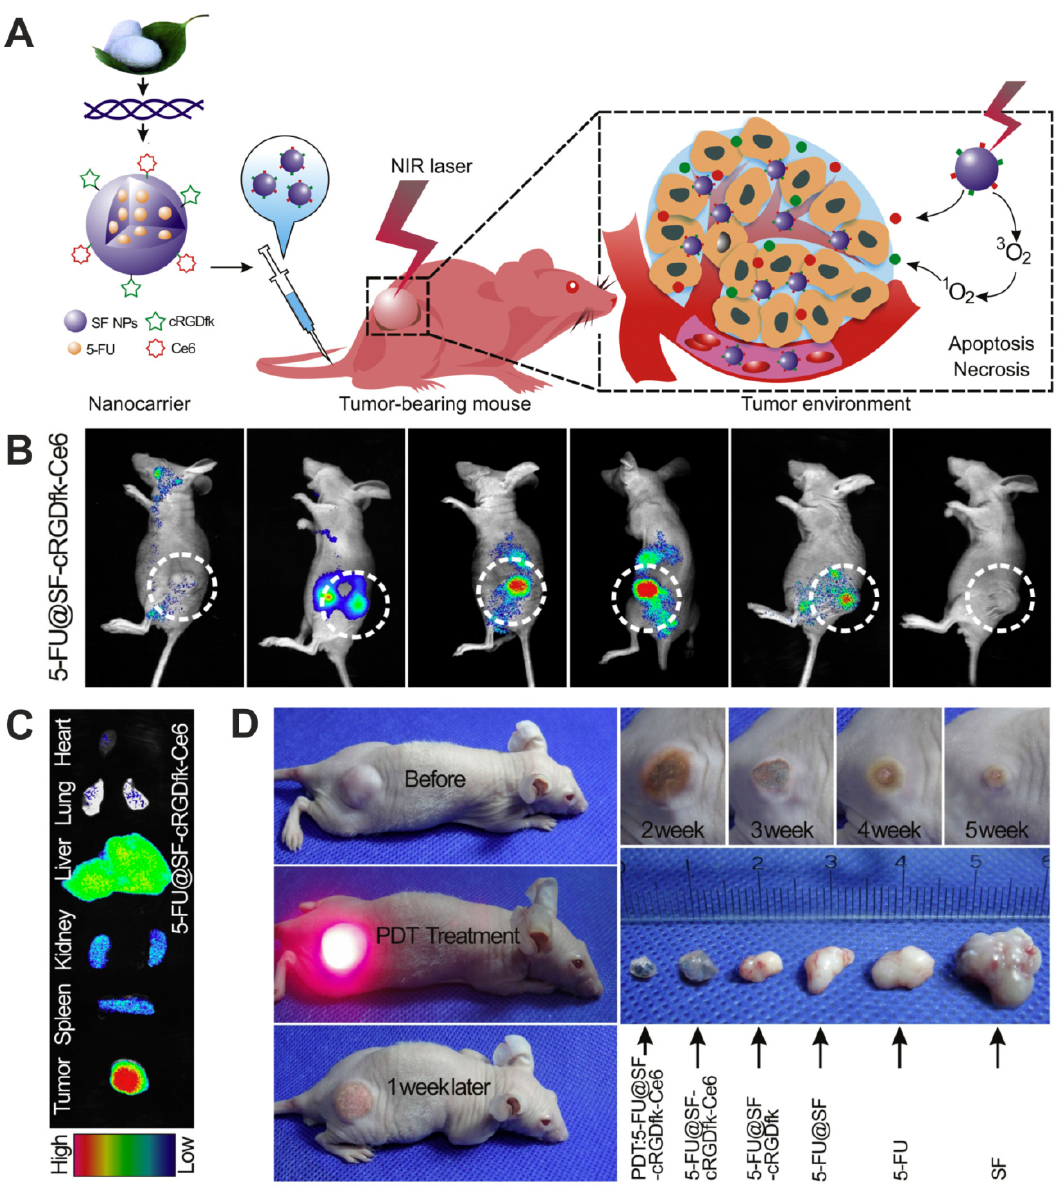
Figure 6. Functionalized silk fibroin nanoparticles for multimodal targeted chemotherapy and photodynamic therapy. ( A ) Schematic illustration of the SF-based nanocarriers functionalized with cyclic cRGDfk peptide, chlorin e6 and 5-FU for in vivo MGC-803 gastric cancer treatment. ( B ) In vivo dynamic fluorescence of 5-FU@SF-cRGDfk-Ce6 NPs injected to MGC-803 tumor-bearing mice (5-FU dose = 5 mg/kg). ( C ) Ex vivo fluorescent images of organs and tumor tissue 24 h post-injection of 5-FU@SF-cRGDfk-Ce6 NPs. ( D ) In vivo therapeutic efficacy of SF-based NPs and PDT. The tumor volumes after the